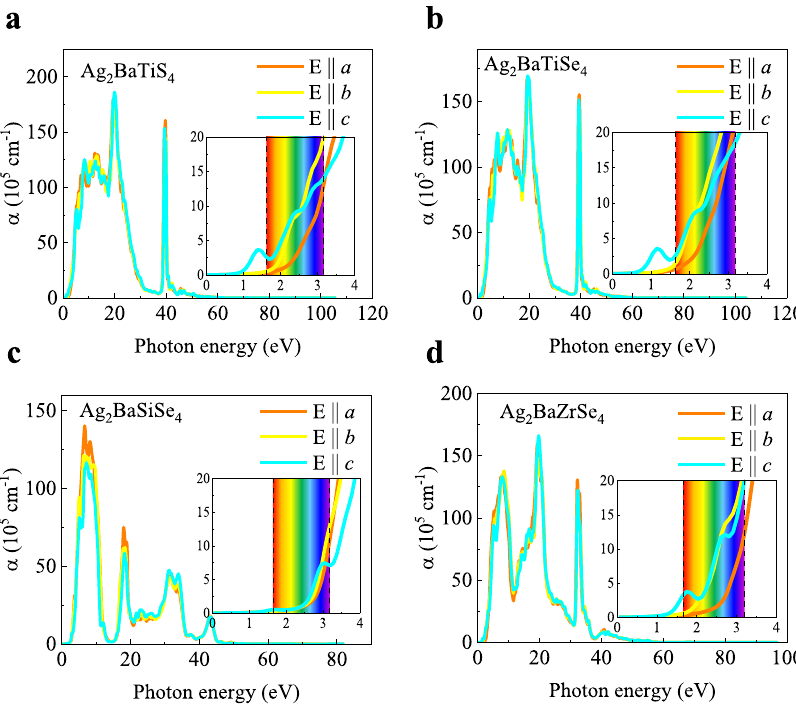
Fig. 6 Calculated optical absorption coef fi cients of four I 2 -II-IV-X 4 chalcogenides. a Ag 2 BaTiS 4 , b Ag 2 BaTiSe 4 , c Ag 2 BaSiSe 4 , d Ag 2 BaZrSe 4 . E || a parallel to reciprocal a axis, E || b parallel to reciprocal b axis, and E || c parallel to the reciprocal c axis. The optical absorption coef fi cients of the other four I 2 -II-IV-X 4 chalcogenides are provided in Supplementary Fig.